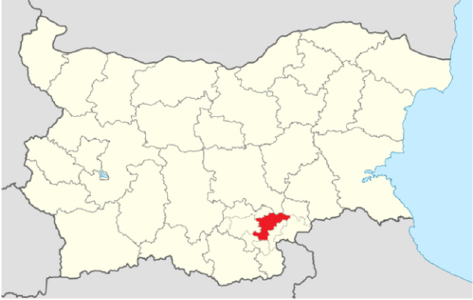
Figure 1. Map of Bulgaria with location of Harmanli Municipality (in red color).